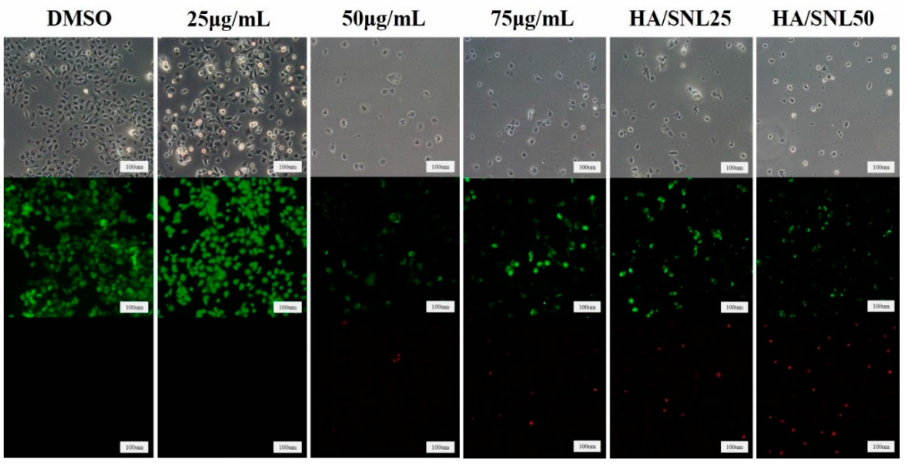
Figure 6. Live/dead assay of A549 cells after a 24-h treatment with SNL or HA/SNL aggregates. The fluorescence micrographs show the live (green) and dead (red) A549 cells after